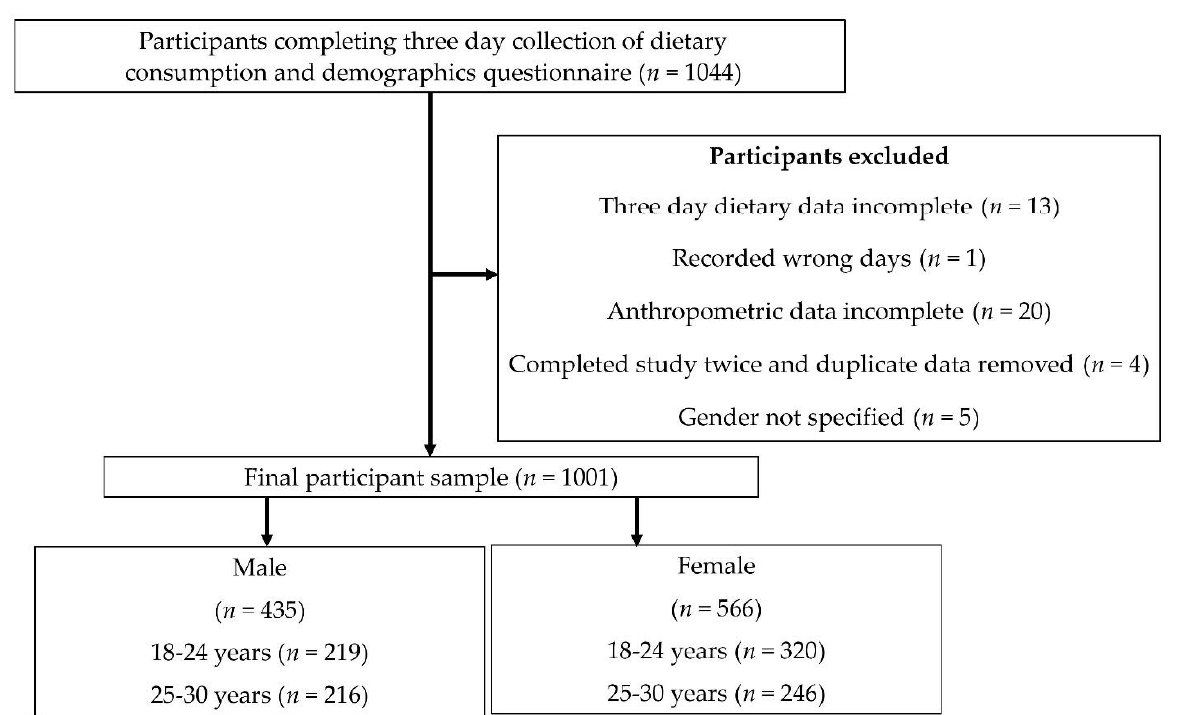
Figure 1. Flow diagram of the study design and final participant sample.